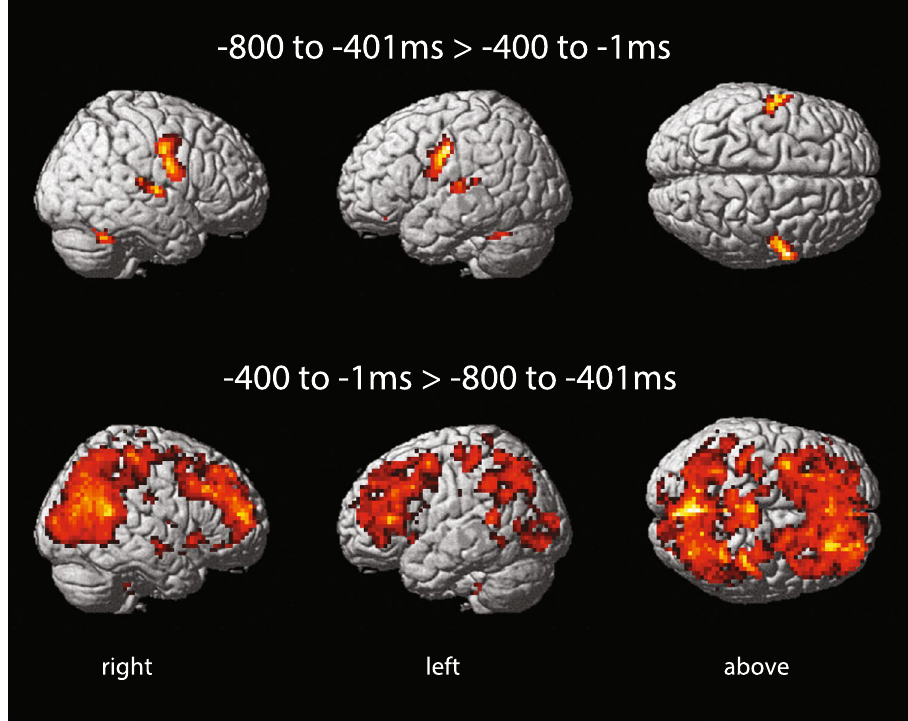
Figure 4. Experiment 1 BOLD effects * in contrasts of pre-RT epochs * p < 0.001 uncorrected for illustrative purposes; extent threshold k E ≥ 10. SPMs rendered on an ICBM individual